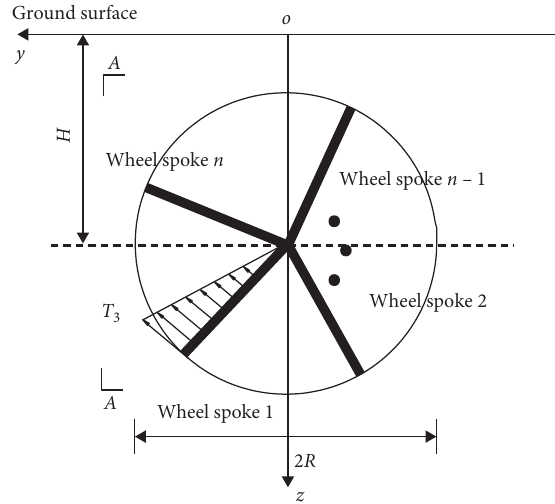
Figure 4: Calculation model of soil deformation caused by frontal friction of the shield machine cutter